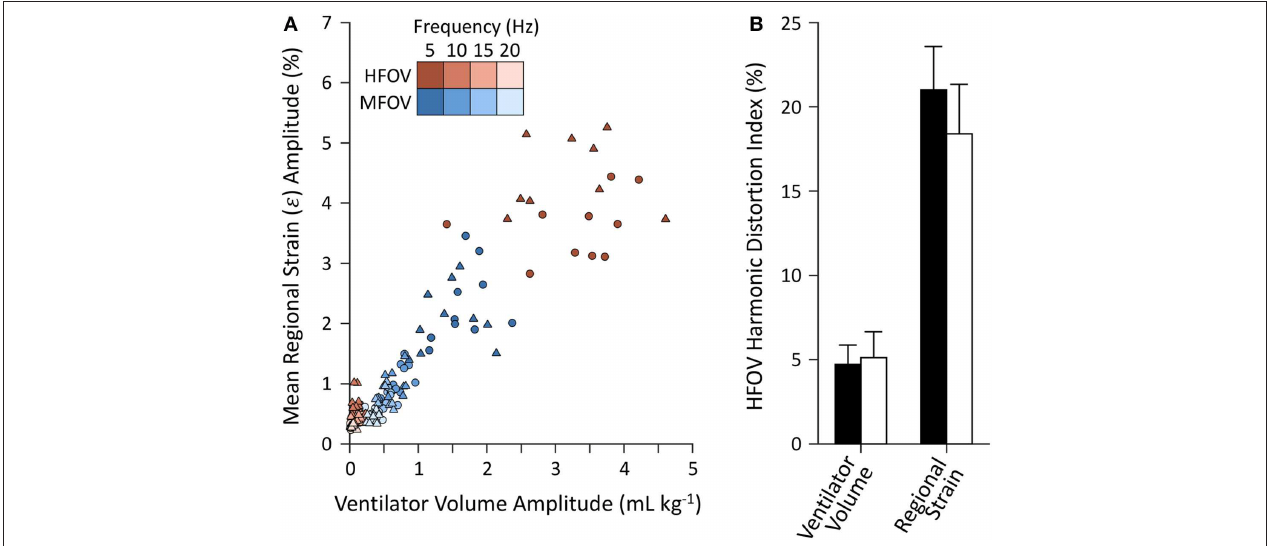
FIGURE 11 | Harmonic amplitudes (A) from imaging-based regional strain measurements and corresponding amplitudes from the ventilator volume waveform measured at the airway opening under baseline (circles) and injured (triangles) conditions. Harmonic distortion index (B) mean and standard deviation for each set of measurements, grouped by baseline (black) and injured (white) lung